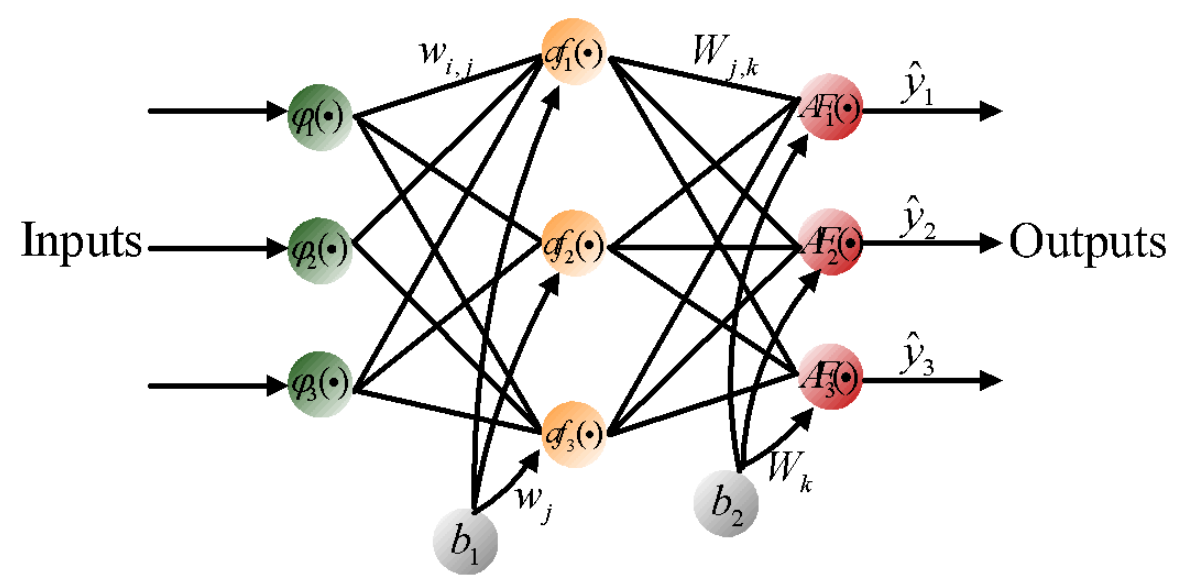
Figure 6. A fully connected Two Layer Feed Forward